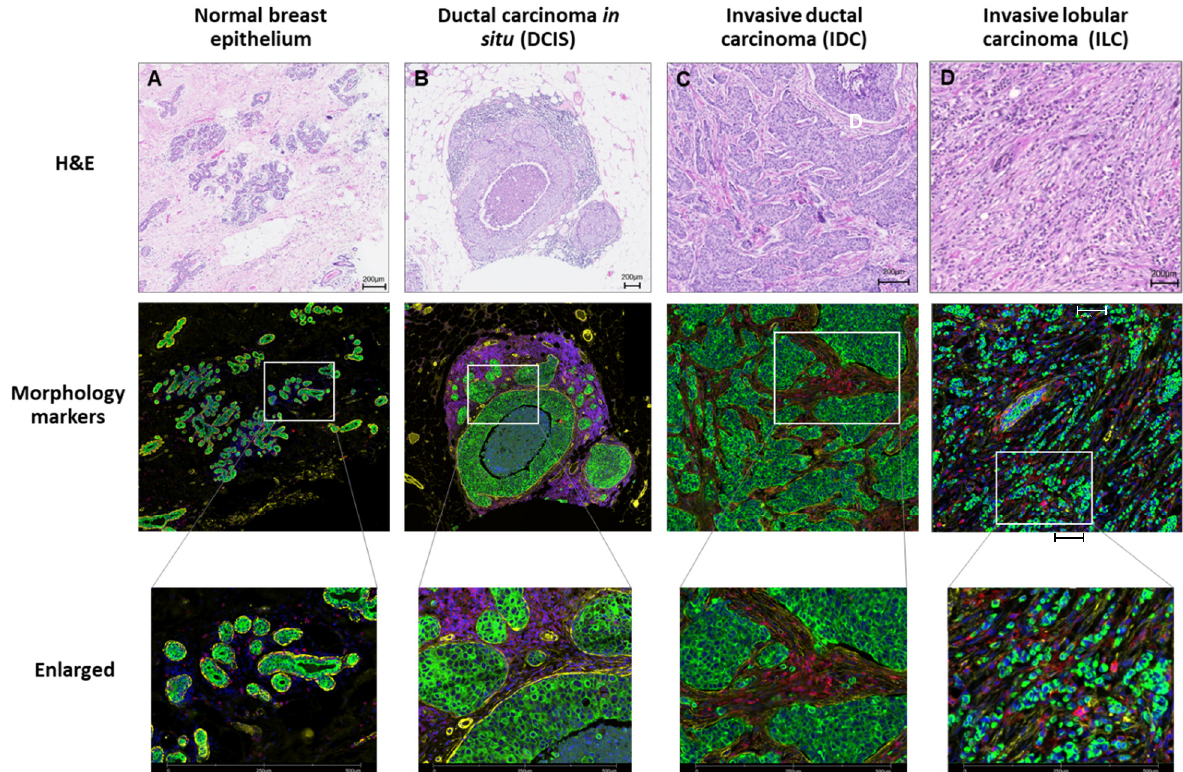
Figure 3. Representative images of non-invasive and invasive breast carcinoma based on histopathological subtypes. ( A ) Normal breast epithelium adjacent to invasive ductal carcinoma. ( B ) Ductal carcinoma in situ (DCIS) from concurrent invasive breast cancer. ( C ) Invasive ductal carcinoma (IDC). ( D ) Invasive lobular carcinomas (ILC). Hematoxylin and eosin (H&E) staining (upper panels). Morphology markers (middle and lower panels): PanCK (green), CD45 (red), smooth muscle actin (yellow) and DNA (blue). The boxed area is enlarged for better visualization. Scale bar: 200 µm.